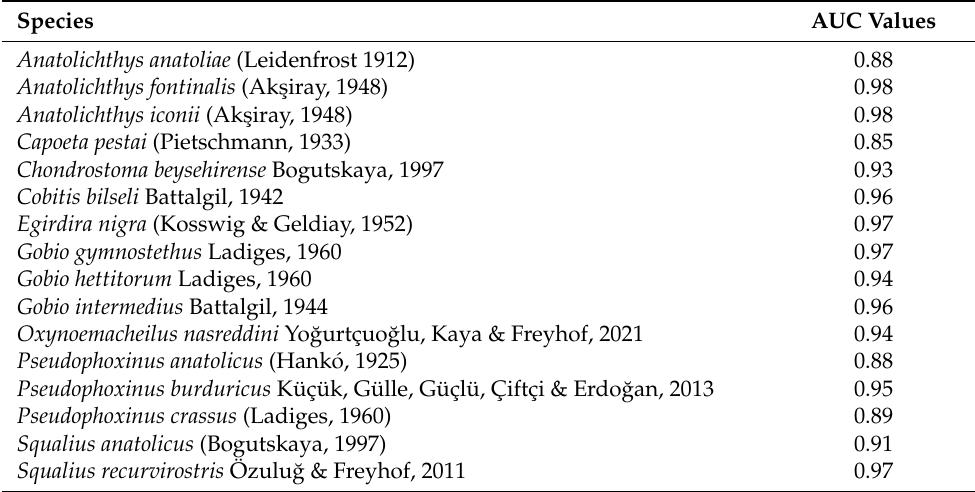
Table 1. Area under the receiver operating characteristic curve (AUC) values for the 16 endemic freshwater fish distribution models.